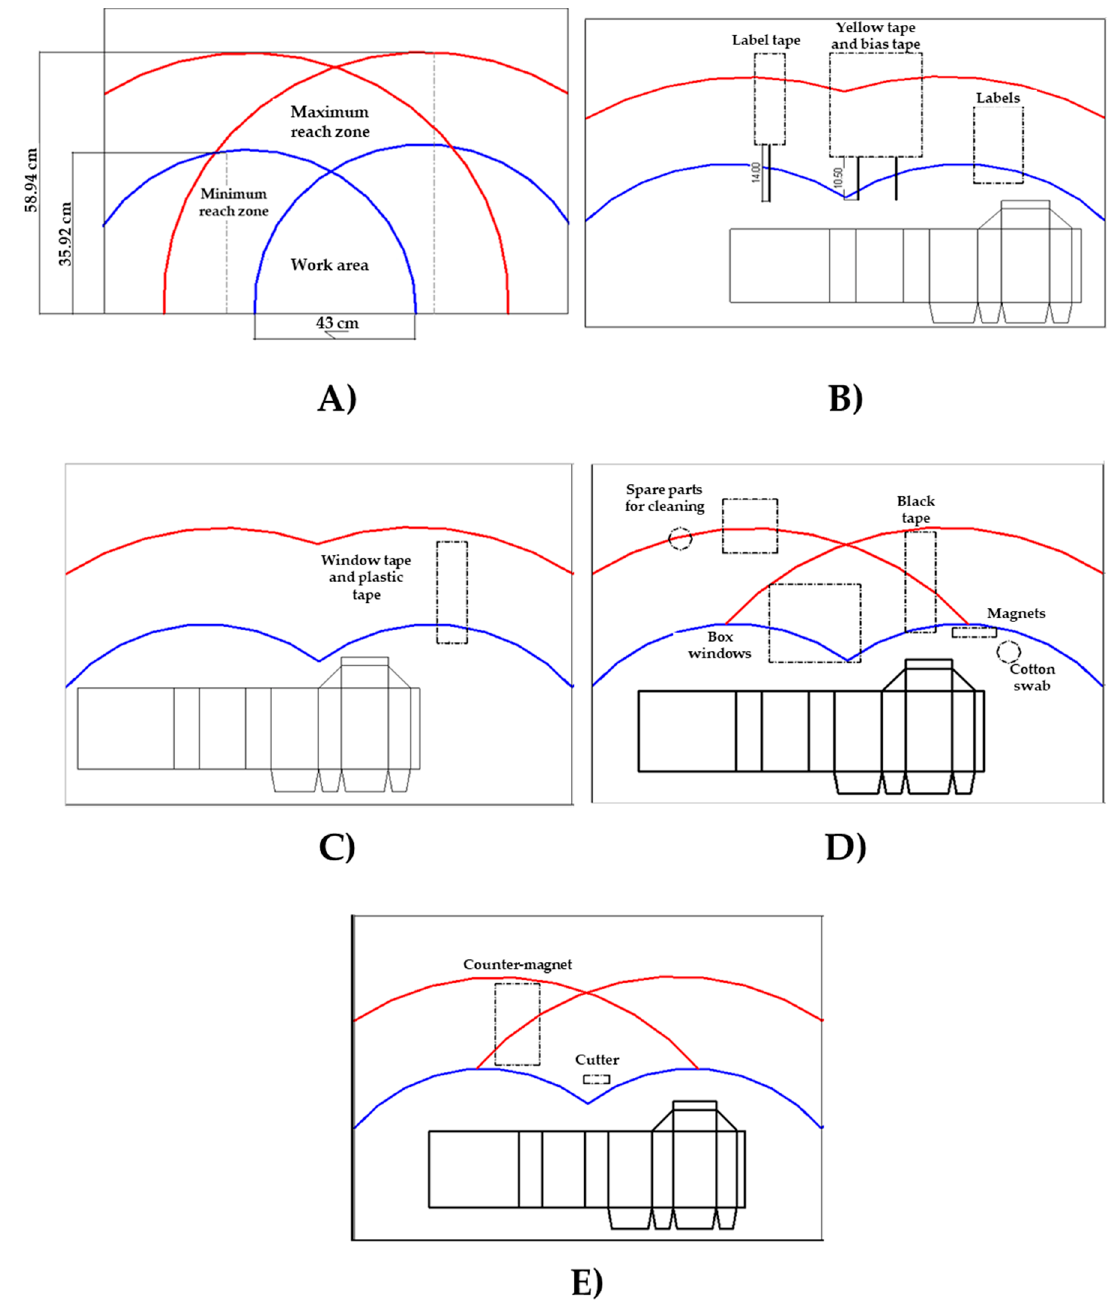
Figure 3. Workstation designs: ( A ) Overall design, ( B ) Workstation 1, ( C ) Workstation 2, ( D ) Workstation 3, ( E ) Workstation 4. Table 8. Inefficient therbligs in the redesigned process.